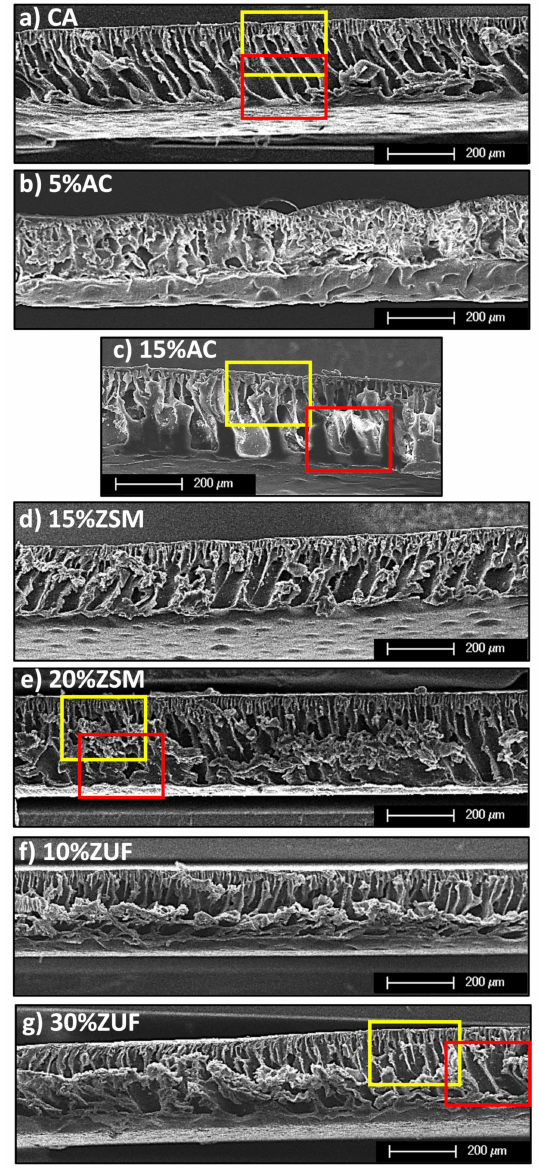
Figure 2. SEM images of the membranes cross section. ( a ) pure CA membrane; MMMAs containing ( b ) 5% of AC; ( c ) 15%AC; ( d ) 15% ZSM-5; ( e ) 20% ZSM-5; ( f ) 10% ZUF; ( g ) 30%